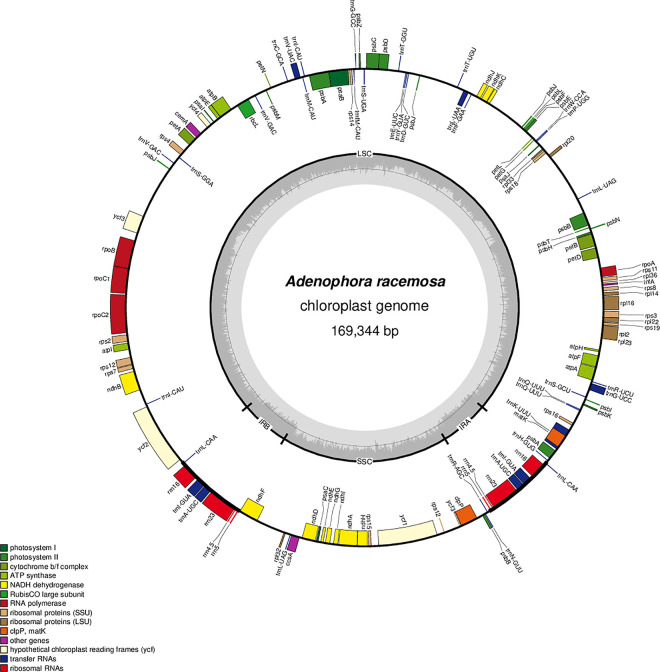
Gene map of the Adenophora racemosa chloroplast genome.Genes inside the circle are transcribed clockwise, and genes outside are transcribed counterclockwise. The dark grey inner circle corresponds to the GC content, and the light-grey circle corresponds to the AT content.